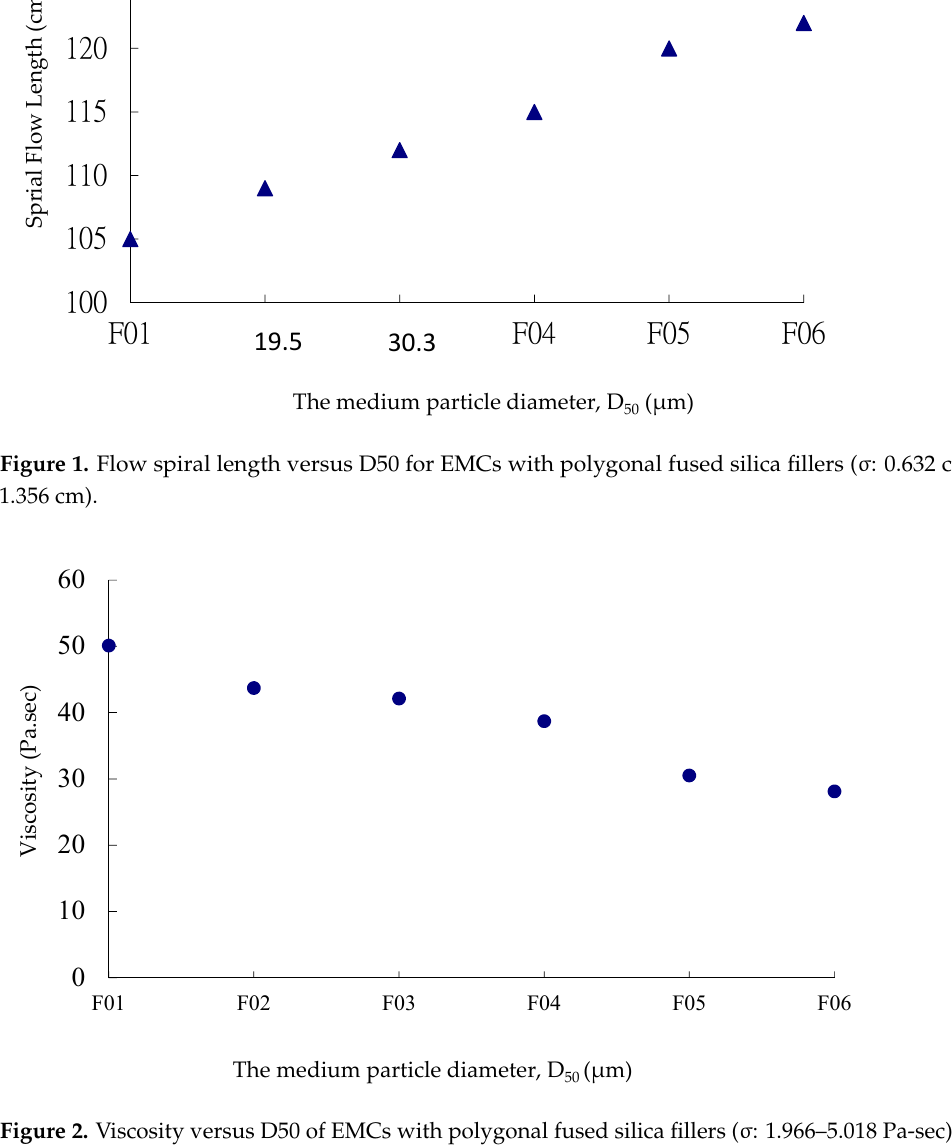
Figure 2. Viscosity versus D50 of EMCs with polygonal fused silica fillers ( σ : 1.966–5.018 Pa-sec). For the effect of silica types and shapes, the fillers of similar D50 were selected. For silica types, the D50 value of C01 was 22 µ m, which was between those of F02 (19.5 µ m) and F03 (30.3 µ m). For silica shapes, the D50 value of S01 was 28.2 µ m, which was close to that of F03 (30.3 µ m). Hence, for simplicity, F03 was chosen for the comparison of both type and shape effects of fillers. The corresponding comparisons are shown in Figures 3 and 4, respectively. For the silica type effect exhibited by the polygonal fused silica (F03) and polygonal crystal silica fillers (C01), Figure 3a,b shows the comparisons of the spiral length and viscosity of the respective EMCs. The result indicates that the EMC with polygonal crystal silica fillers flowed slightly better. For the shape effect, the results portrayed in Figure 4 shows that the EMC with spherical fused silica fillers flowed better than that with polygonal fused silica fillers.